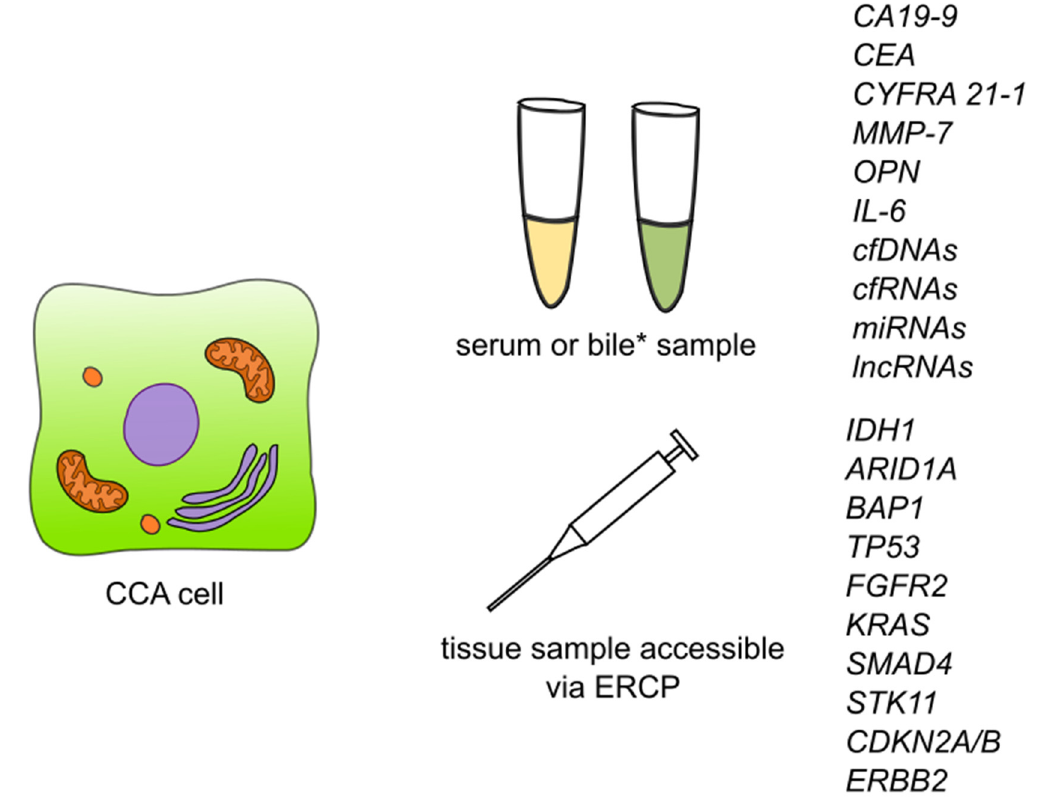
Figure 3. Summary of detection of biomarkers and some of the genetic markers for cholangiocarcinoma. Abbreviations: CA19-9—carbohydrate antigen 19-9/cancer antigen 19-9; CEA—carcinoembryonic antigen; CYFRA 21-1—cytokeratin fragment antigen 21-1; MMP-7—metalloproteinase 7; IL-6—interleukin 6; cfDNAs—circulating free DNAs; cfRNAs—circulating free RNAs; lncRNAs—long non-coding RNAs; ERCP—endoscopic retrograde cholangiopancreatography; IDH1 —isocitrate dehydrogenase (NADP(+)) 1; ARID1A —AT-rich interaction domain 1A; BAP1 —BRCA1 associated protein 1; TP53 —tumor protein P53; FGFR2 —fibroblast growth factor receptor 2; KRAS —KRAS proto-oncogene, GTPase; SMAD4 —SMAD family member 4; STK11 —serine/threonine kinase 11; CDKN2A/B —cyclin dependent kinase inhibitor 2A/cyclin dependent kinase inhibitor 2B; ERBB2 —Erb-B2 receptor tyrosine kinase 2. * Detection of CCA biomarkers in